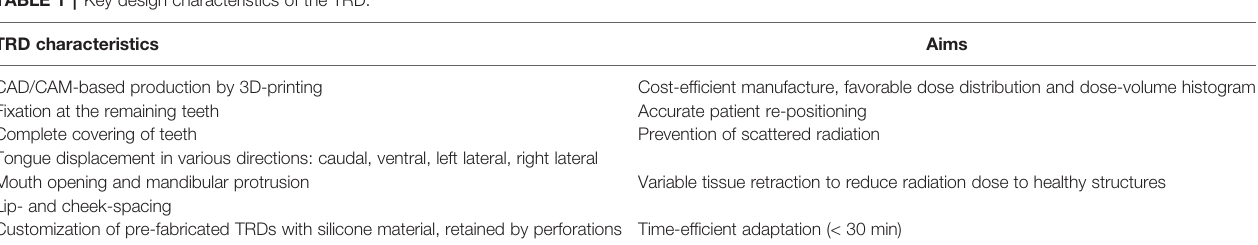
TABLE 1 | Key design characteristics of the